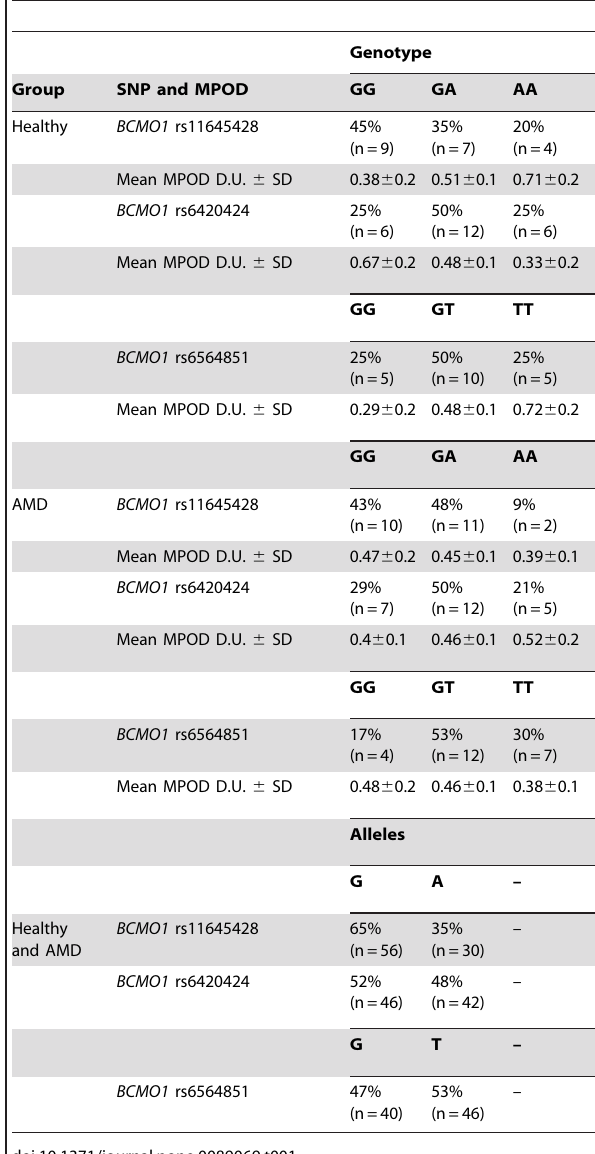
Table 1. Genotype and allele frequencies of the BCMO1 SNPs rs11645428, rs6420424 and rs6564851 and mean